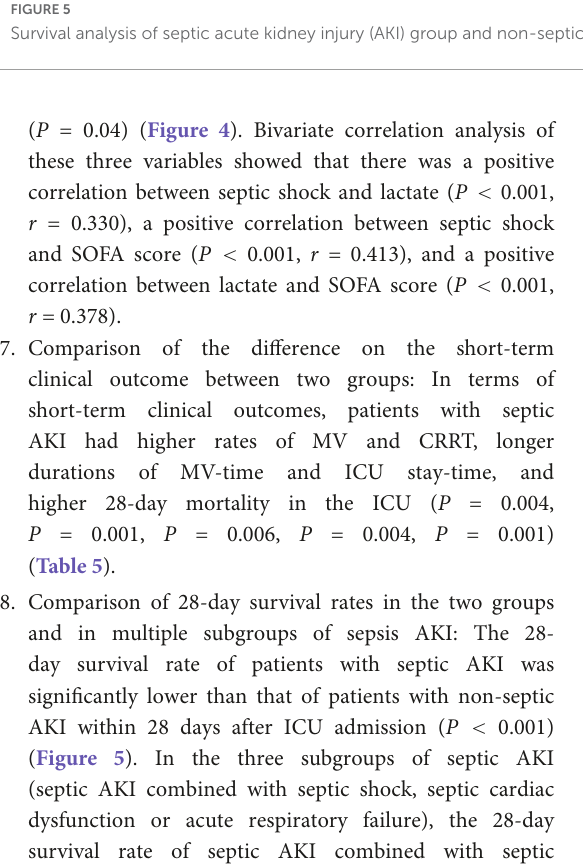
FIGURE5 Survival analysis of septic acute kidney injury (AKI) group and non-septic AKI group.